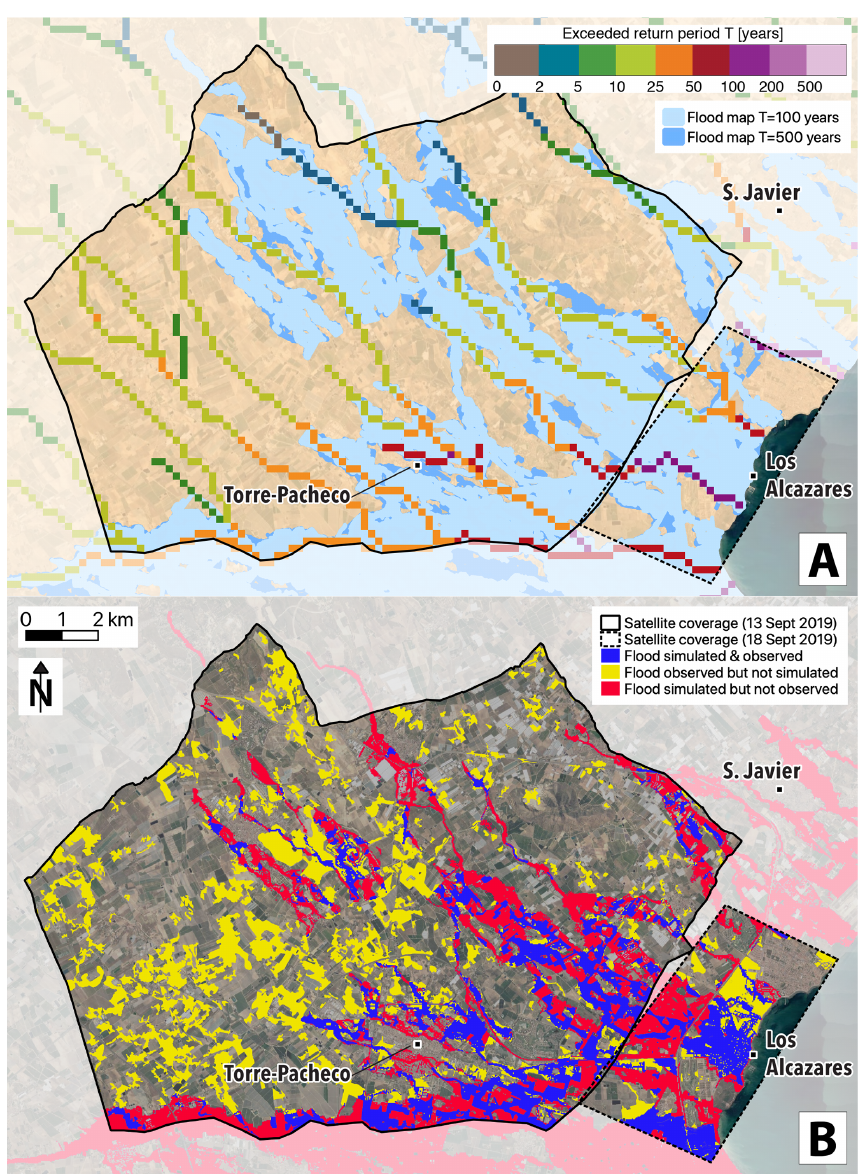
Figure 7. (a) Maximum ERICHA flash flood hazard (11–14 September 2019) and official flood maps used for the simulation of the flood extents in Torre-Pacheco and Los Alcazares (for the location of the shown area, see Fig. 6c). (b) Comparison of the simulated flash flood extents with satellite observations in Torre-Pacheco (13 September 2019 10:50UTC) and in Los Alcazares (18 September 2019 10:51UTC). Map data © Google Earth